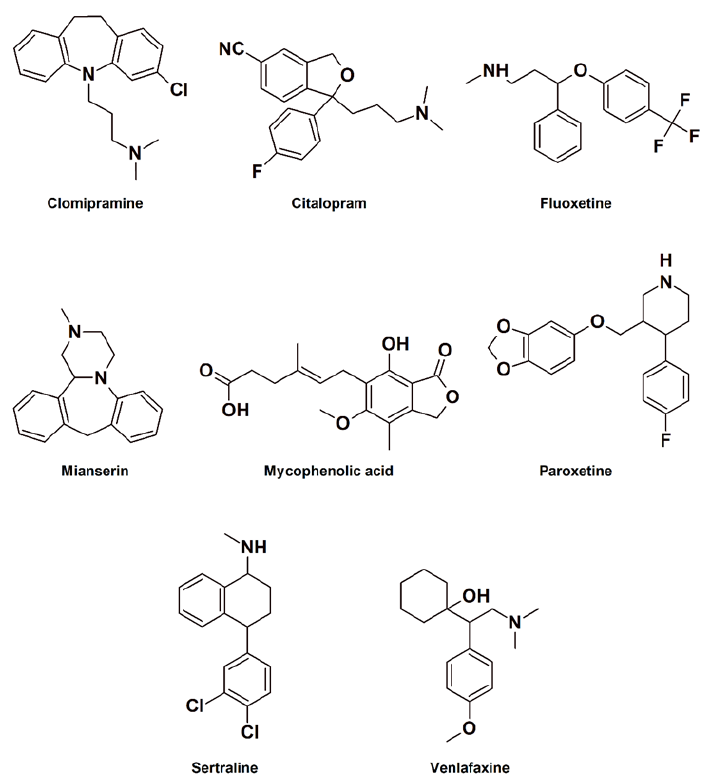
Figure 6. Structures of PhACs used in the study.